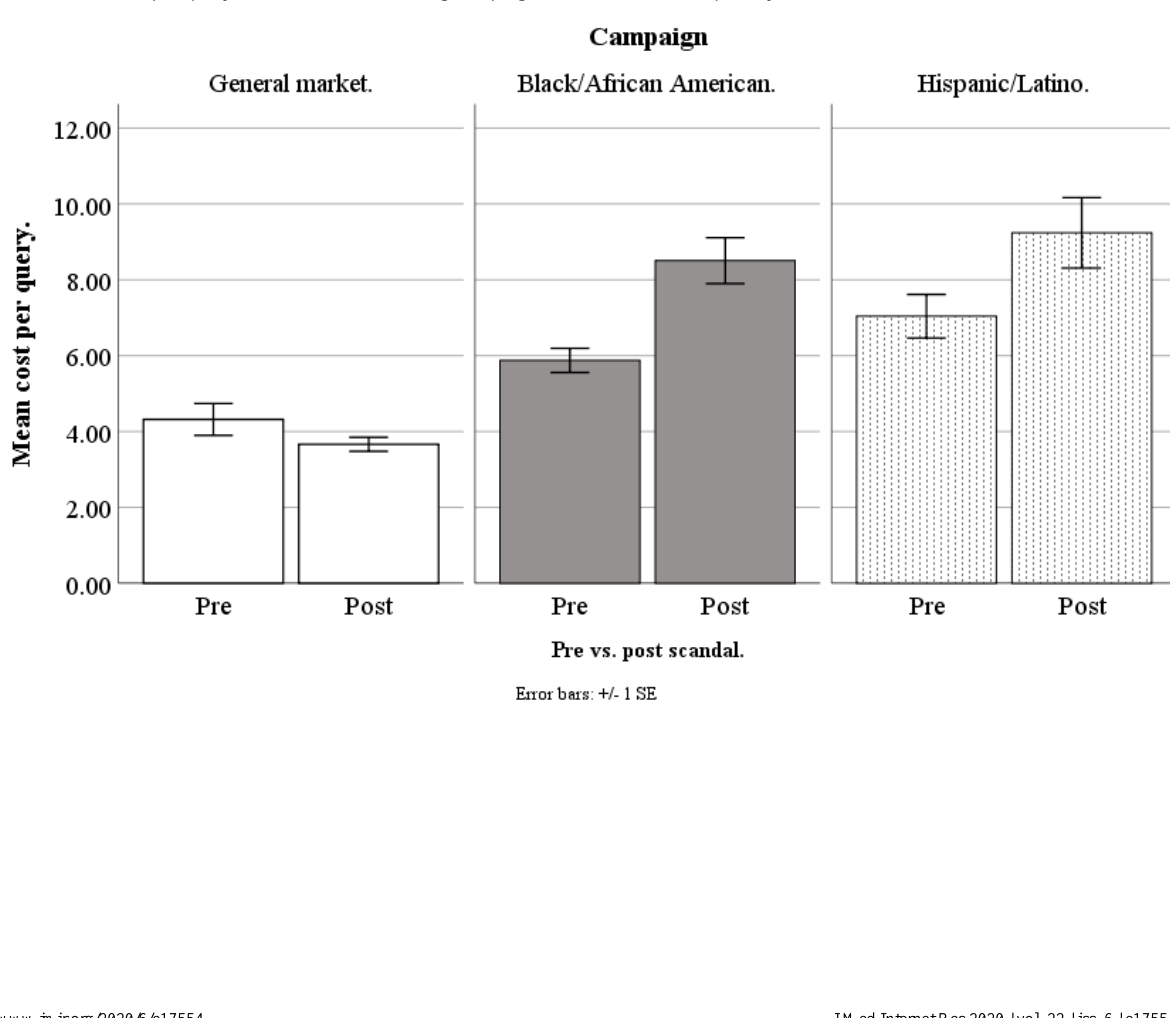
Figure 15. Mean costs per query for Facebook advertising campaigns before versus after privacy